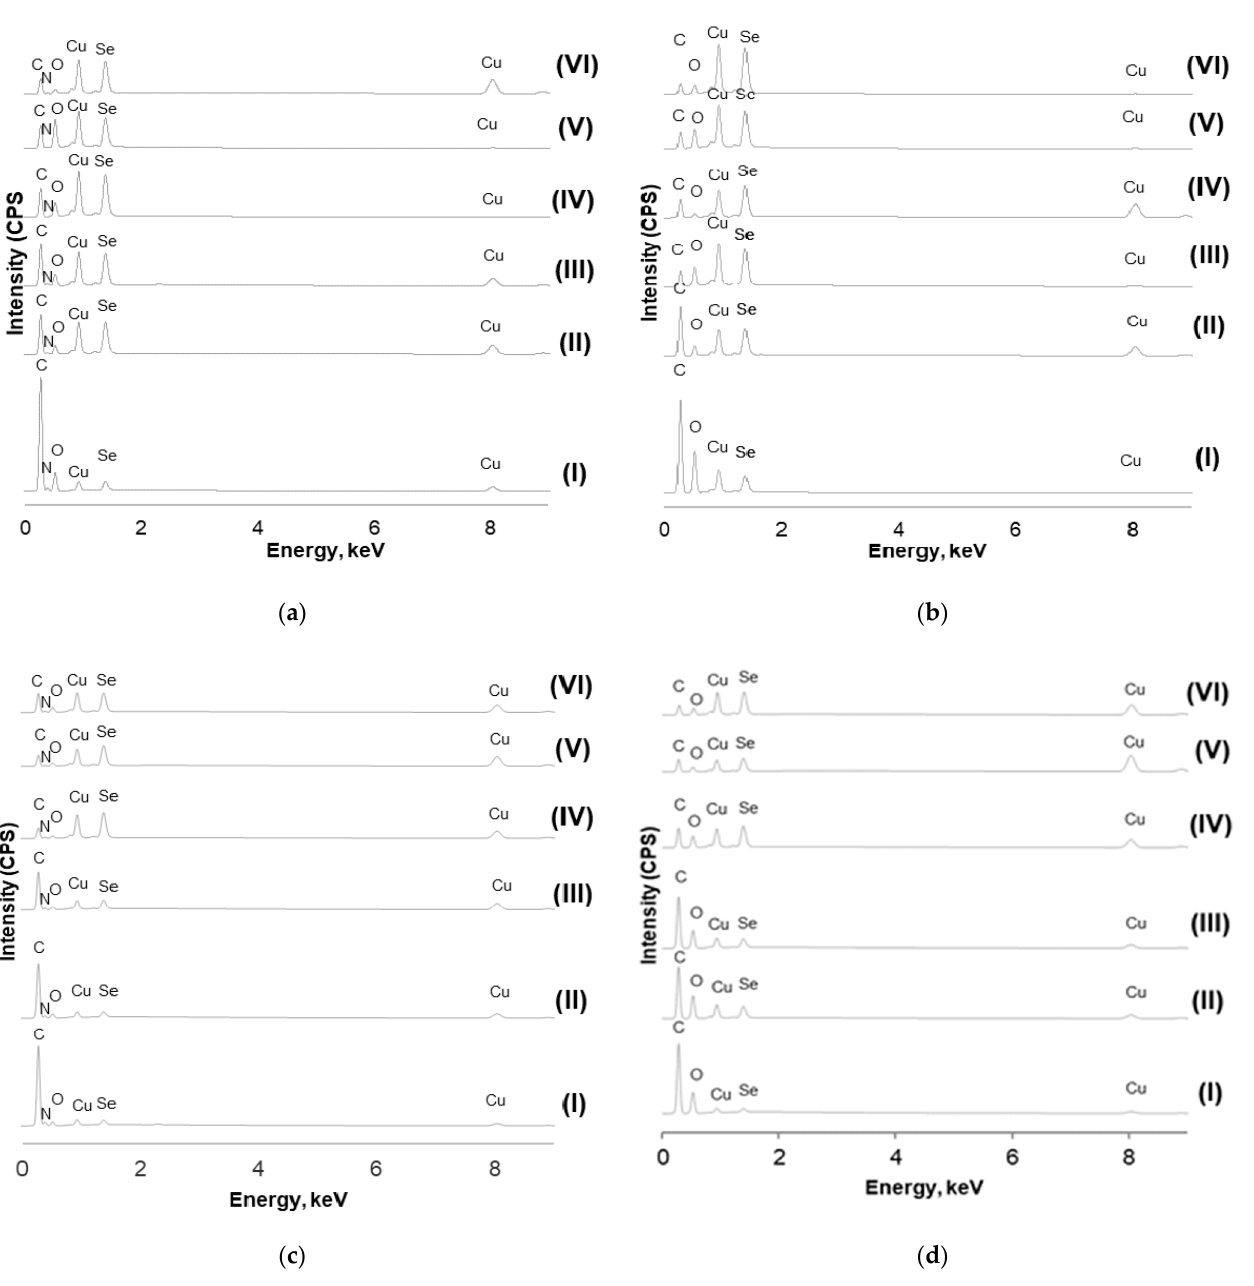
Figure 11. EDX spectra of treated synthetic samples after different numbers of cycles: ( a ) PA6, ( b ) PA66, ( c ) PAN, and ( d )